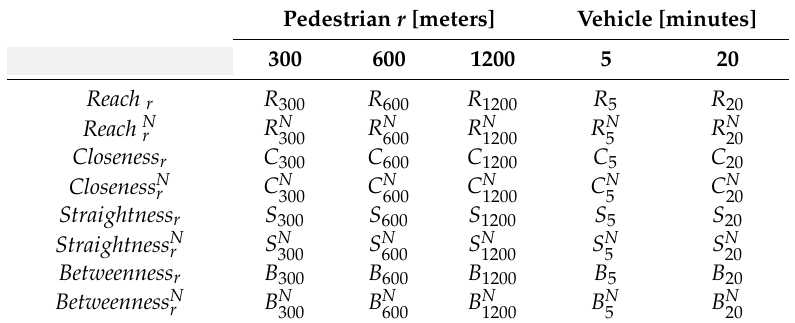
Table A2. Summary table of the 40 street-network configurational indicators. r , radius; n ,